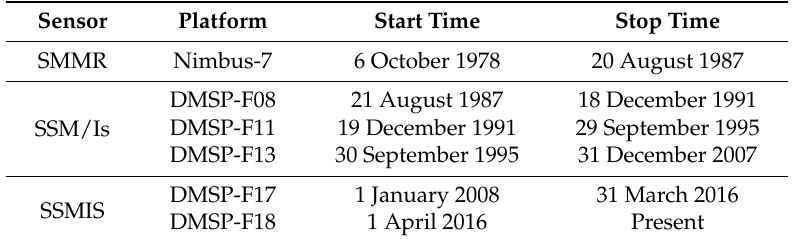
Table 1. Passive microwave sensor platform and the start and stop using time of data.